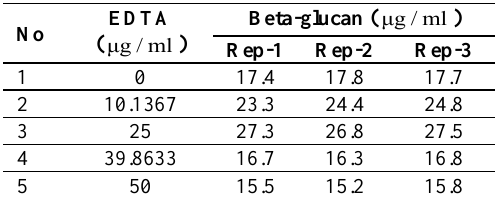
Table 3. Data set for EDTA and BG.